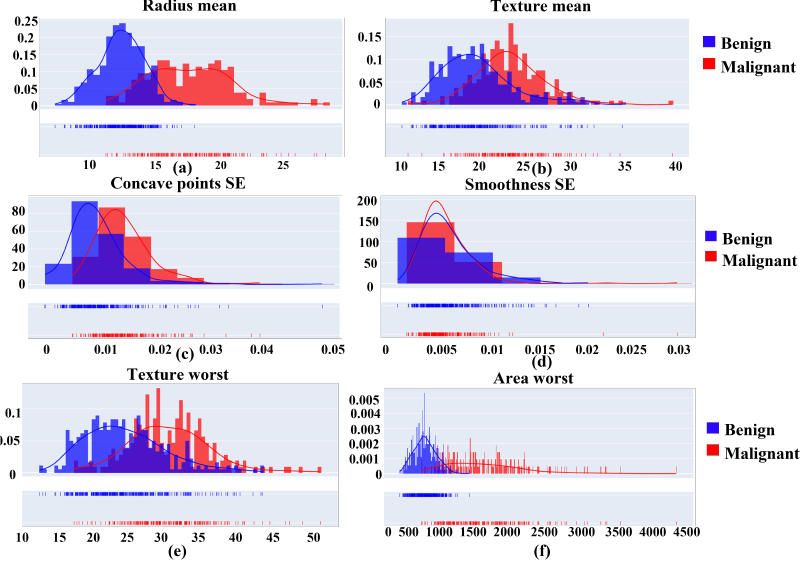
Figure 3. Feature distribution of WDBC dataset with samples of ( a ) Radius mean, ( b ) Texture mean, ( c ) Concave points SE, ( d ) Smoothness SE, ( e ) Texture worst, and ( f ) Area